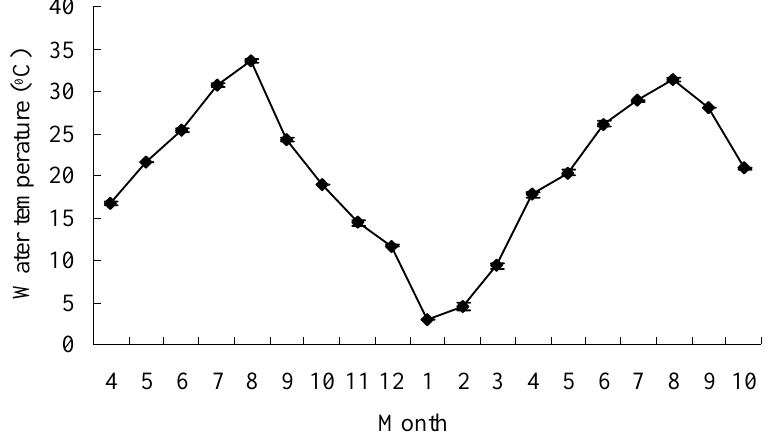
FIGURE 1. Temporal variations of water temperature (°C) during the study